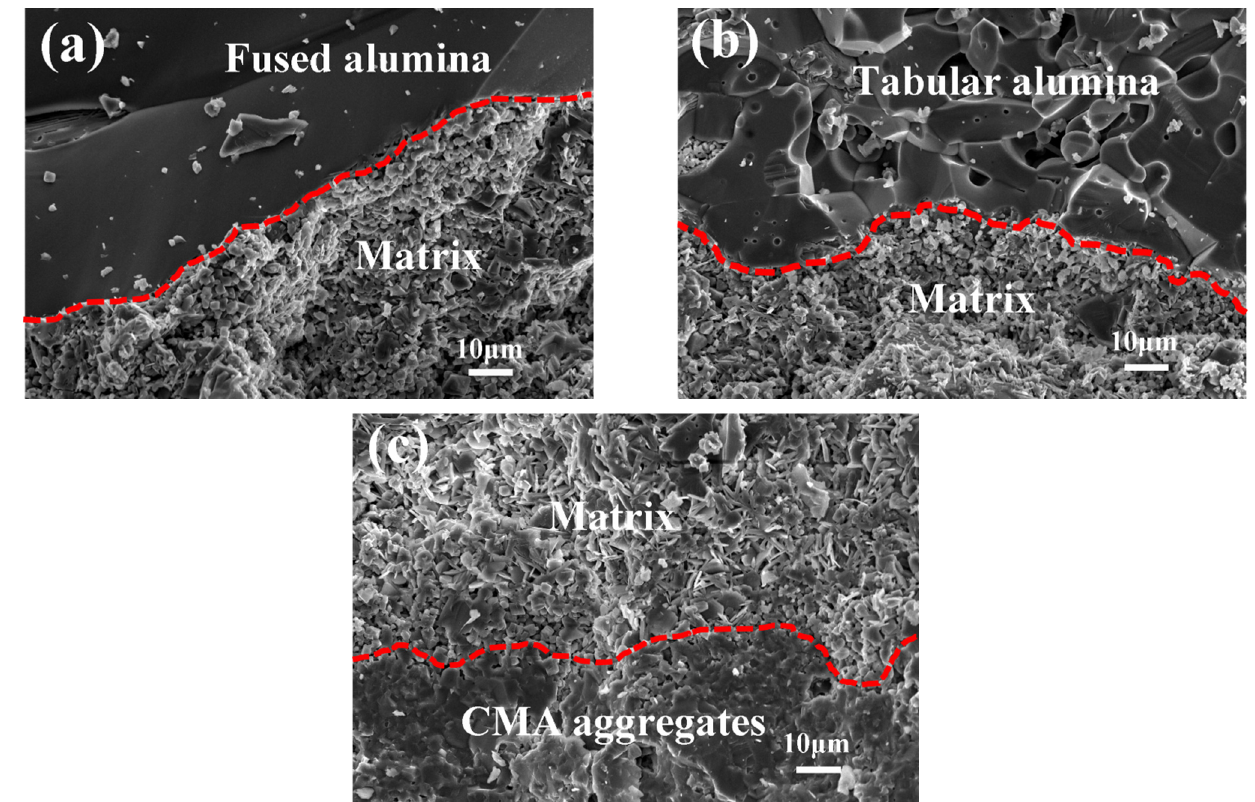
Figure 3. Microstructure of the bonding interfaces between the matrix and aggregates in castables calcined at 1550 °C for 3 h: ( a ) Fused alumina, ( b ) tabular alumina and ( c ) CMA aggregates.